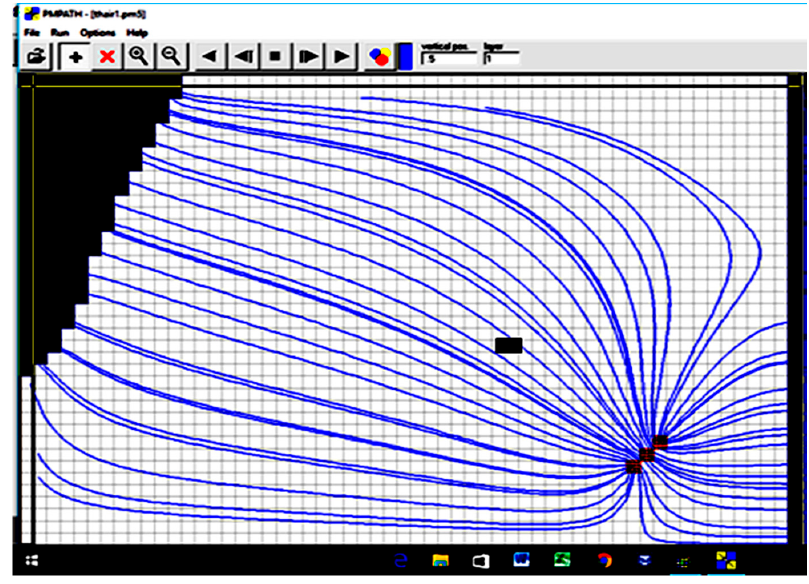
Figure 6. Groundwater flow directions for Scenario 1.